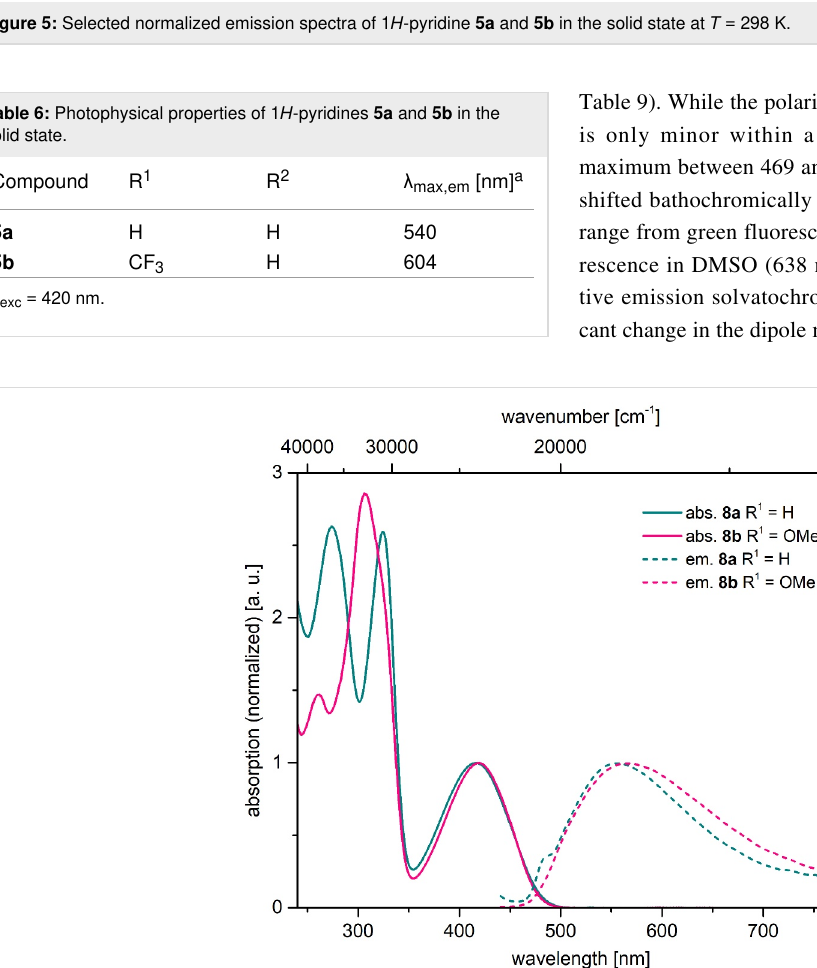
Figure 5: Selected normalized emission spectra of 1 H -pyridine 5a and 5b in the solid state at T = 298 K.